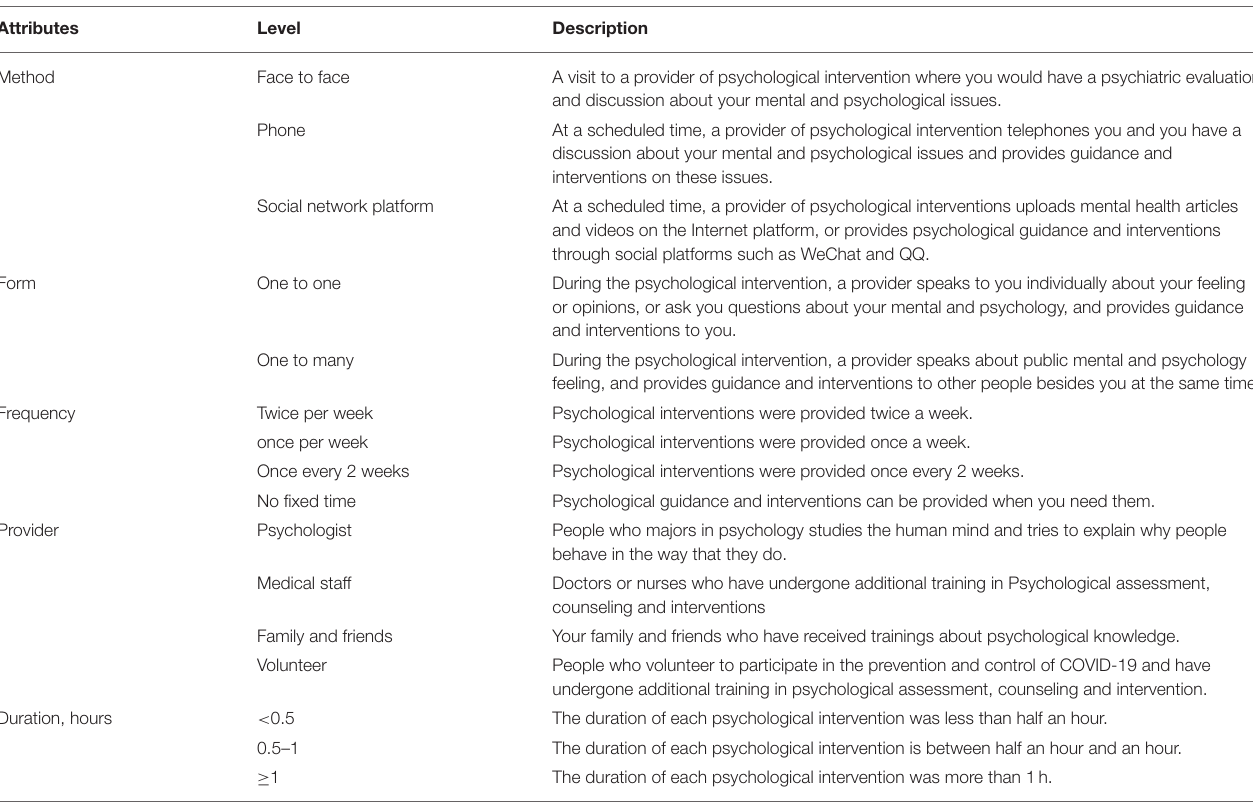
TABLE 1 | Attributes and levels. Attributes Level Description